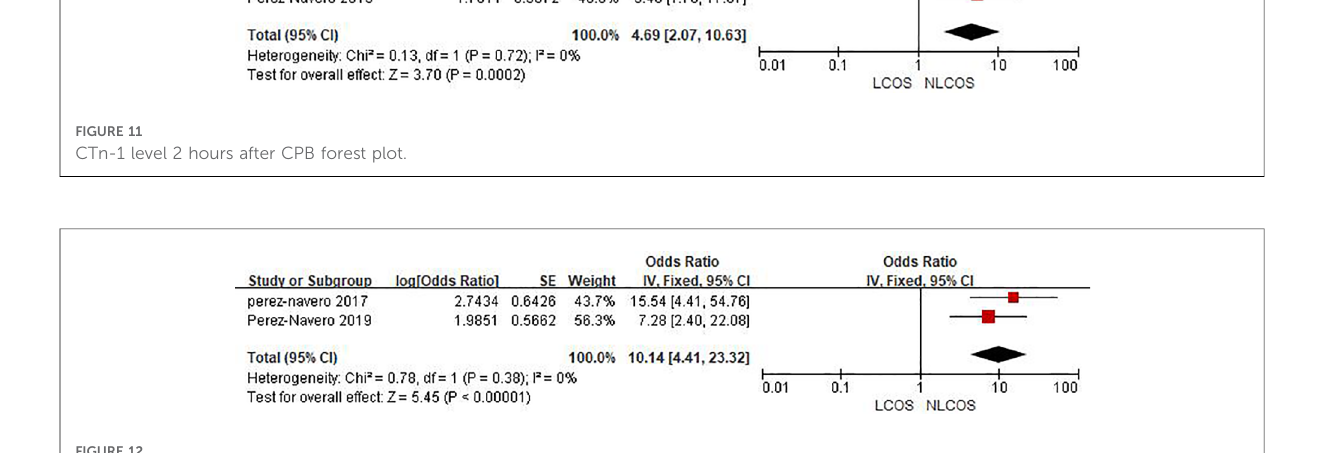
FIGURE 12 Postoperative 24h MR-ProADM level forest